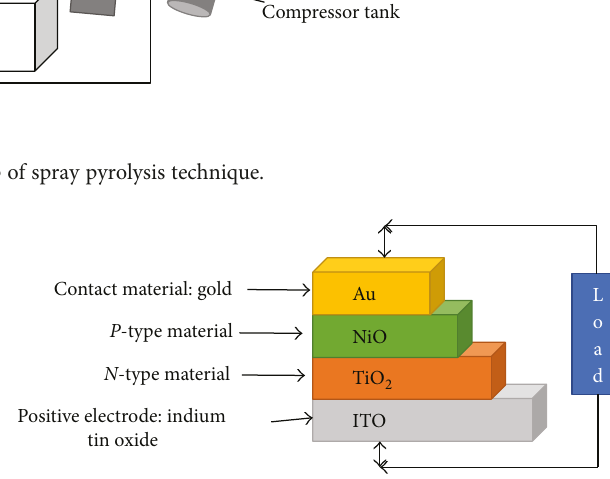
heterojunction 2